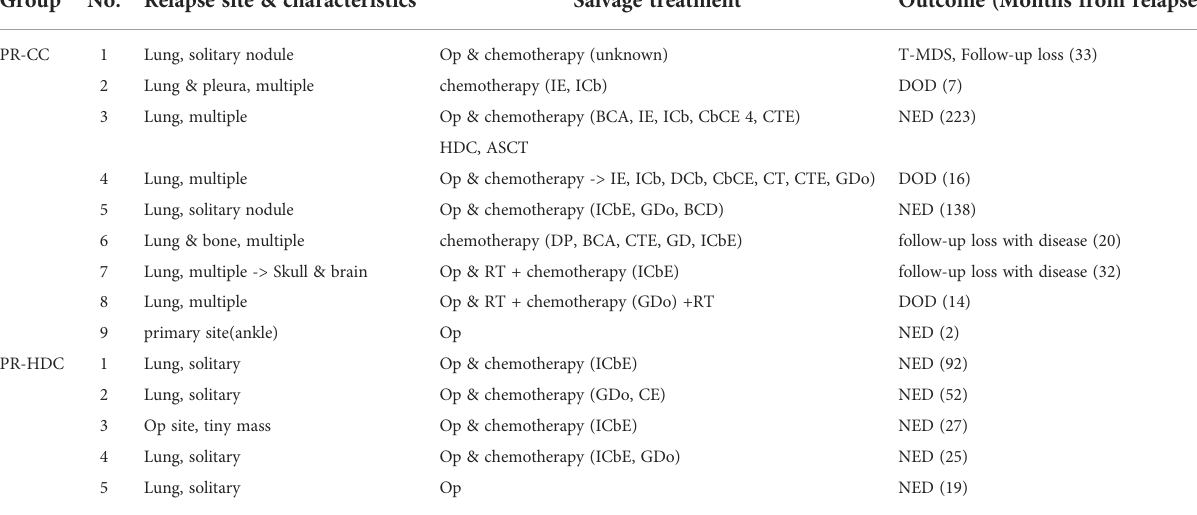
TABLE 3 Relapse sites and salvage treatments of the poor response groups. Group